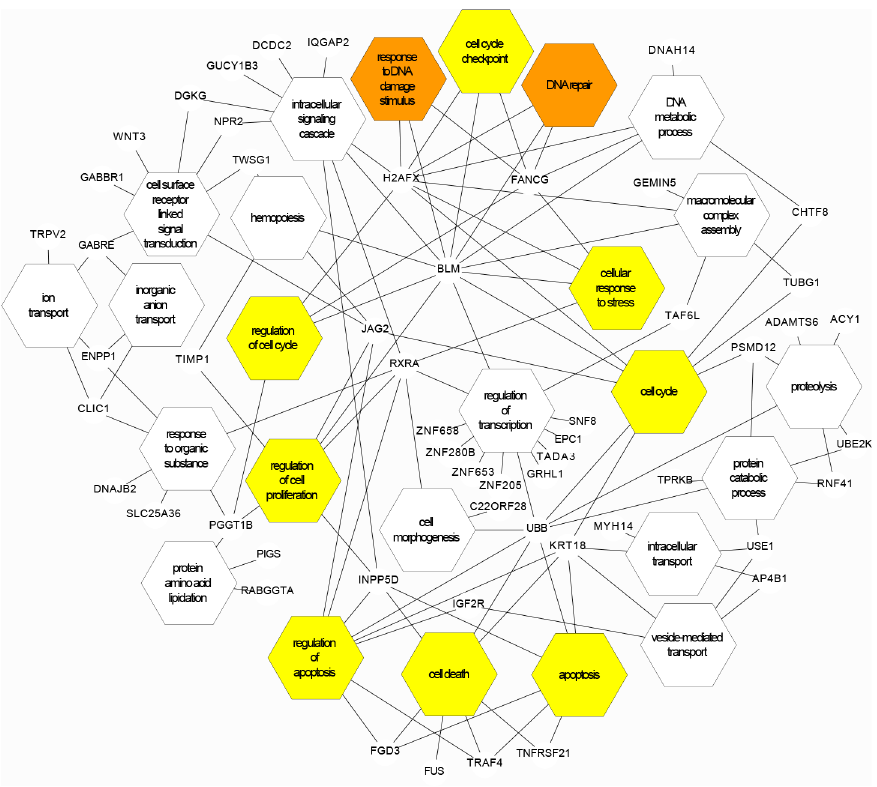
Fig 4. The 6 hour network cartoon built from the 102 genes differentially expressed at p < 0.05. Genes differentially expressed to p < 0.05 in human pulmonary vascular EC treated for 6 hours with 10 μ M iron (II) citrate (S5 Table) were entered into automated clustering programmes, and clustered into 17 “ biological process ” annotation categories. The network cartoon was built from the full set of clustered genes, and from the most inclusive and/or relevant representative terms from each cluster. 6 clusters were also obtained for “ molecular function ” , but were not included in the diagram for simplicity. Note that hub genes H2AFX , FANCG , and BLM highlight DNA damage/repair